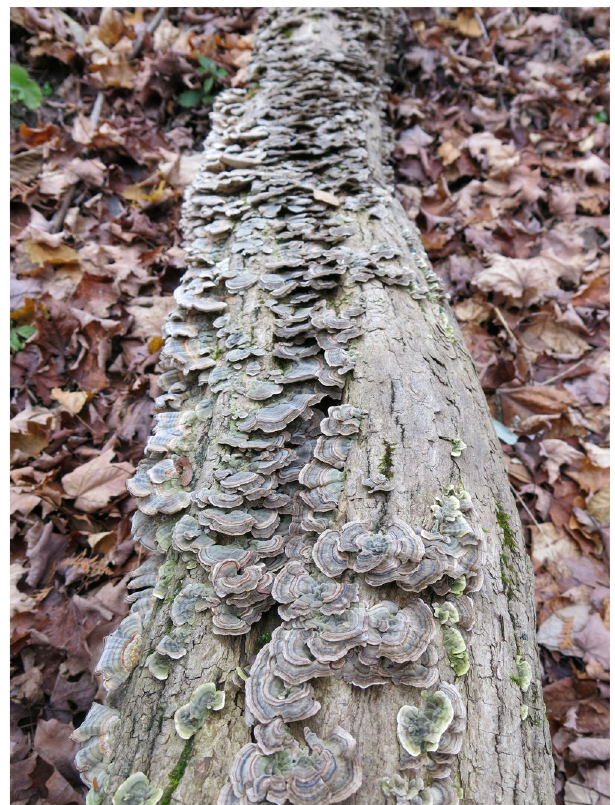
Figure 1. The fruiting bodies of Trametes versicolor analyzed in our